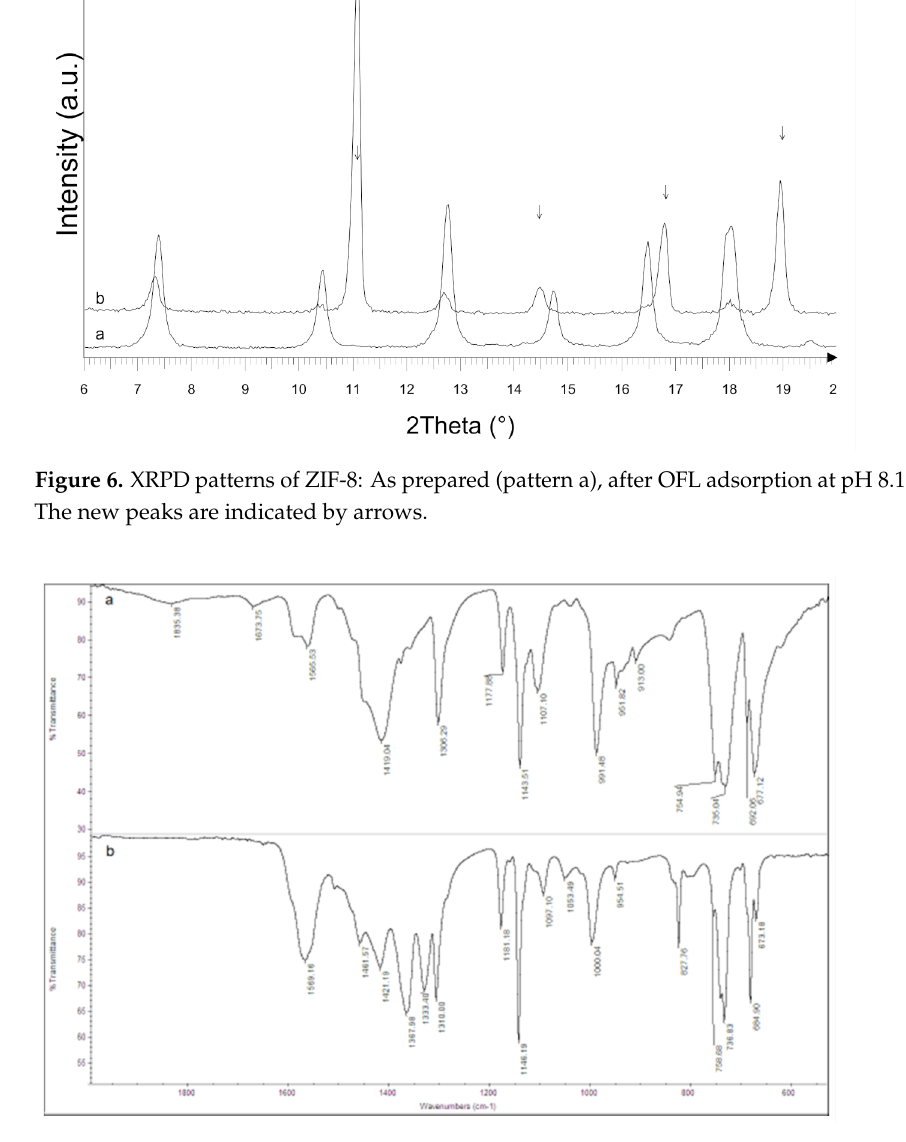
Figure 7. FT-IR spectra of ZIF-8: As-synthesized (spectrum a) and after OFL adsorption at pH 8.1 (spectrum